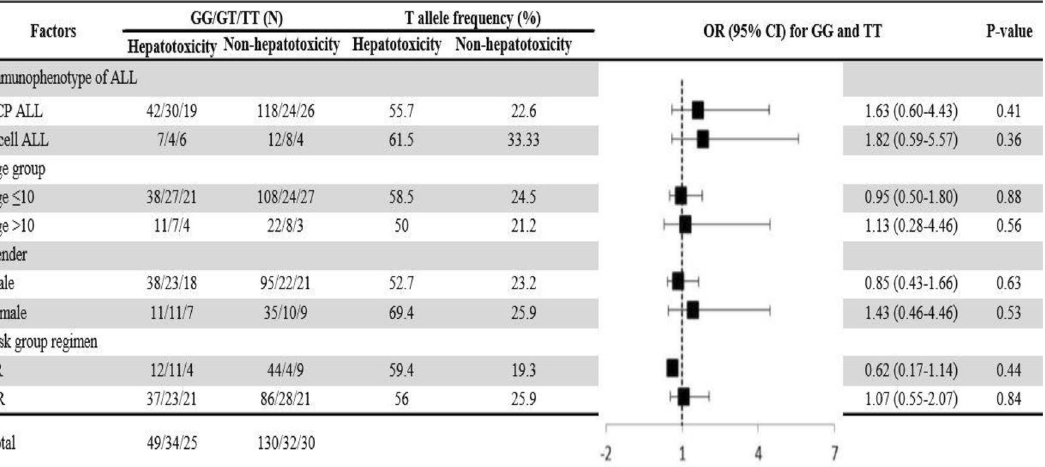
Figure 4. Adjusted association between ABCC1 (rs4148350) genotypes and risk of hepatotoxicity.